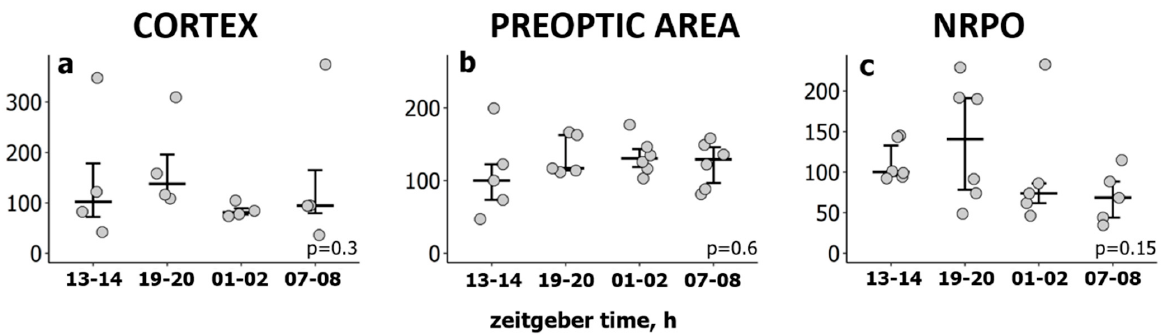
Figure 3. Hsp70 protein levels in ( a ) the sensorimotor cortex, ( b ) the preoptic area of the hypothalamus and ( c ) nucleus reticularis pontis oralis (NRPO) during slow-wave sleep (SWS) and REM sleep (REMS). Western blot analysis of the brain structures was run with the antibodies against inducible Hsp70. Hsp70 protein level is presented in relative units of optical density against the level of house-keeping protein GAPDH. Data from rats sacrificed after 5–5.5 min of SWS at ZT01-02 or after 2.5–3.5 min of REMS at ZT07-08 were compared with the data from rats after 10 min of wake at the same time points. X-axis—vigilance states: WAKE—rats were sacrificed after an episode of wakefulness, SWS—after slow-wave sleep, REMS—after REM sleep. Values are shown as mean ± s.e.m, n = 3 for each group. p values were calculated using the Mann–Whitney U test with a corresponding “WAKE” group as a control. Representative immunoblots are shown under the respective graphs. When comparing the Hspa1 expression in the sensorimotor cortex, the POA or the NRPO during wakefulness across the 24 h period, no significant differences were identi- fied (Kruskal–Wallis test: H(3, N = 16) = 3.79, p = 0.3; H(3, N = 22) = 1.74, p = 0.6; H(3, N = 22) = 5.38, p = 0.15, according to the brain area, Figure 4). These data suggest that the cir- cadian rhythm has no significant effect on Hspa1 expression within the studied rat brain areas.